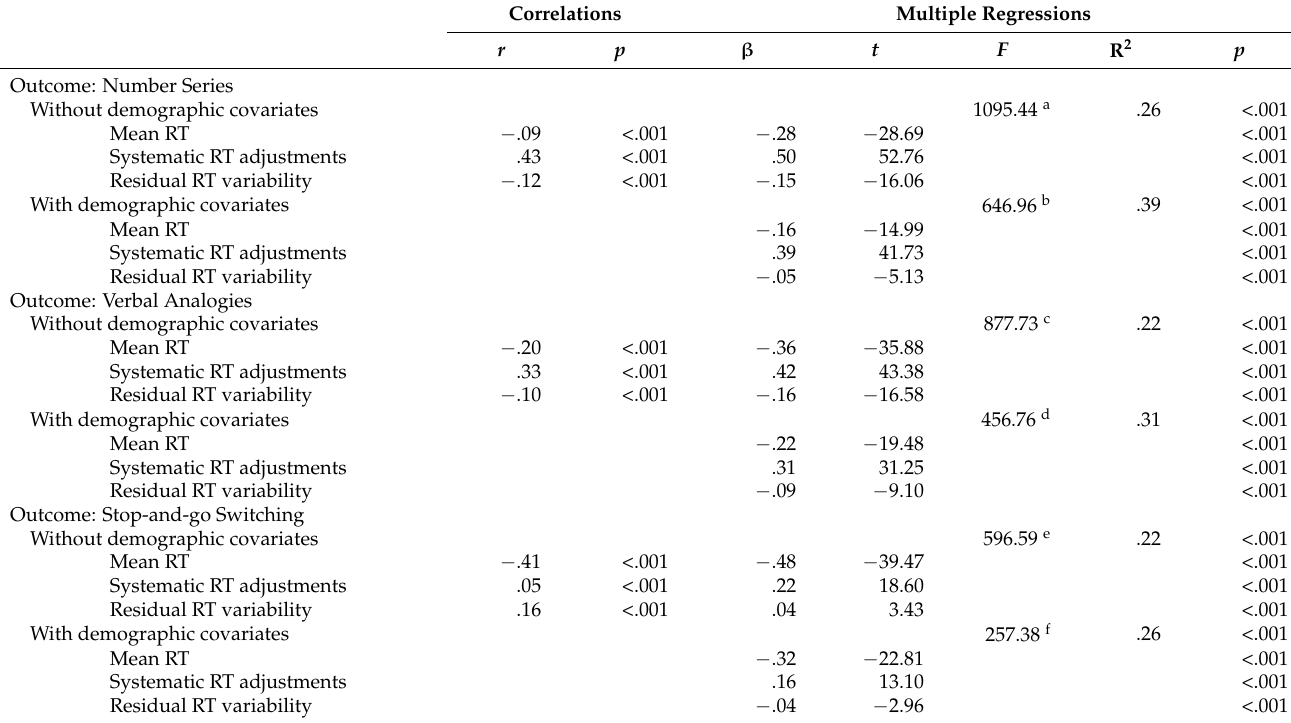
Table 4. Relationships (correlations and standardized regression coefficients) between cognitive test scores and survey item response time components derived from the expanded location-scale model.